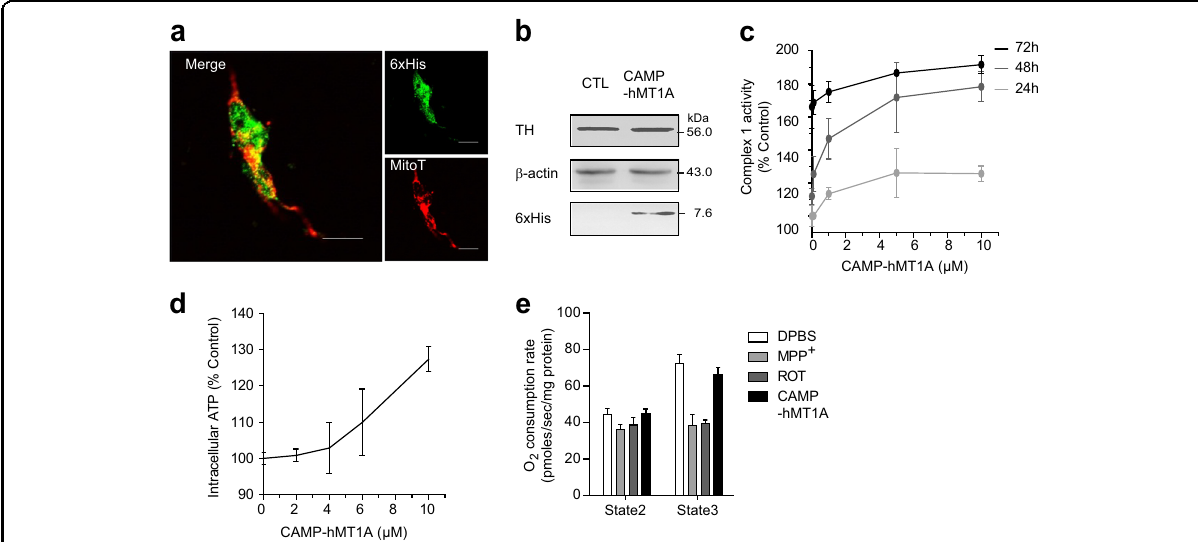
Fig. 5 CAMP-hMT1A increases mitochondrial function in neuronal cells without cytotoxicity. a Confocal microscopy images of CAMP-hMT1A in the mitochondria of SH-SY5Y neuronal cells (×400, scale bar = 10 μ m). Cells were treated with 2 μ M CAMP-hMT1A protein for 24 h, stained with MitoTracker (MitoT, red), and immunostained with 6xHis-tag antibody (green). b Western blot of tyrosine hydroxylase (TH) levels in CAMP-MT1A- or PBS-treated cells. β -Actin was detected as a loading control. c Time- and dose-dependent effects of CAMP-hMT1A on complex 1 of OXPHOS, NADH dehydrogenase activity. d Dose-dependent effects of CAMP-hMT1A on intracellular ATP content. e The oxygen consumption rate (OCR) of isolated mitochondria for state 2 ( – ADP) and state 3 ( + 1.5 mM ADP) respiration were measured, with mitochondrial complex 1 inhibitors MPP + (1 mM) and rotenone (1 μ M) used as positive controls. The data are presented as the mean ± SEM, n = 3